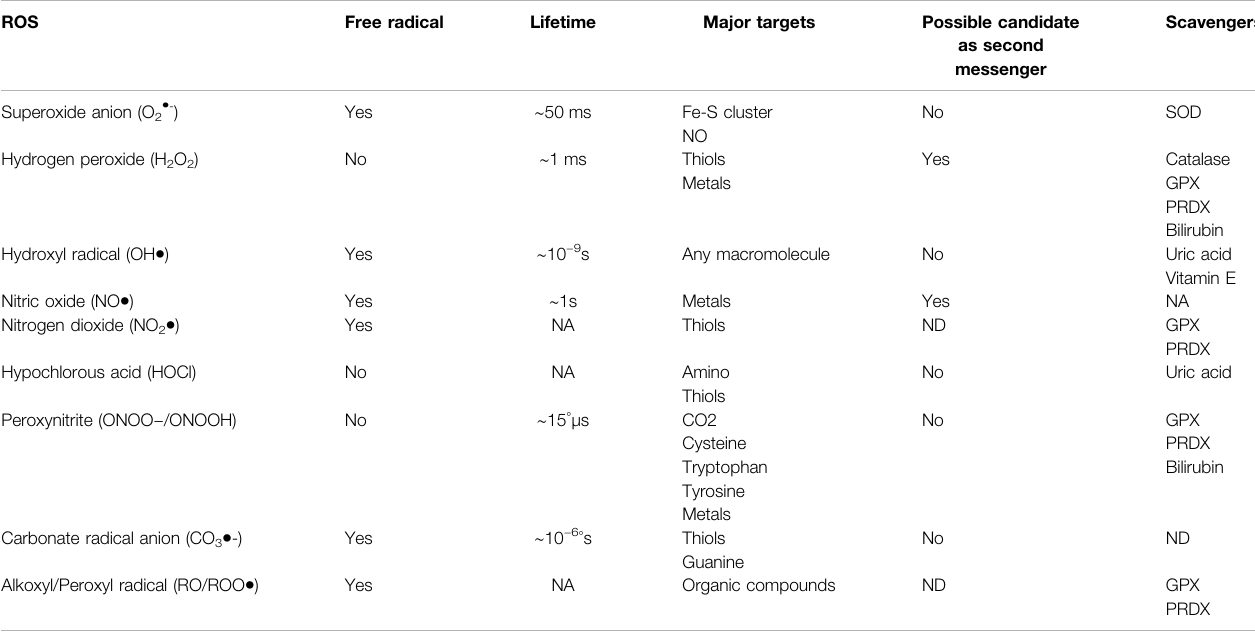
TABLE 1 | Characteristics of some major ROS generated by NADPH oxidases and mitochondria 6,7,16 – 18 .